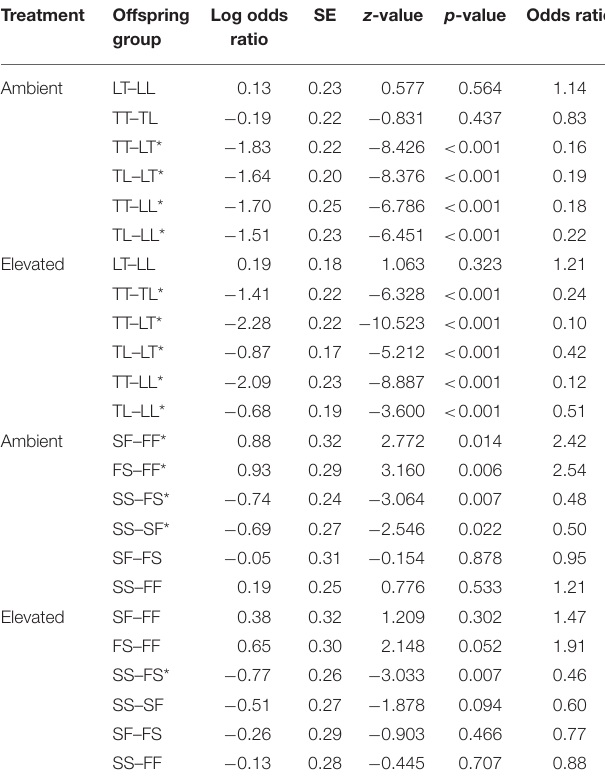
TABLE 4 | Tukey’s pairwise comparisons of survival between the offspring groups from the Acropora tenuis (T) × Acropora loripes (L) cross and the